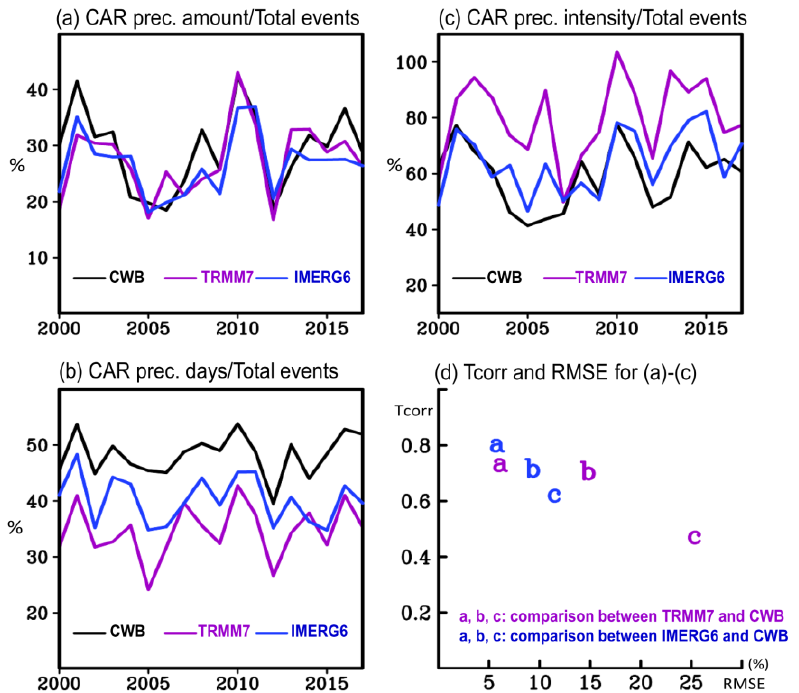
Figure 9. ( a ) The contribution of CAR events to the total precipitation amount that fell during the summers of 2000 – 2017. ( b ) The contribution of CAR days to total rainy days. ( c ) The contribution of CAR intensity (i.e., mean rain rate; unit: mm per event) to the intensity of total rainy events. In  100%. In ( d ), the comparison of Tcorr and RMSE ( a )-( c ), contribution = CAR events Total precipitation events between time series in ( a – c ) is given, using the CWB data as the reference base, and denoted a-b-c, respectively. In ( d ), the purple color and blue color represents results related to TRMM7 and IMERG6,